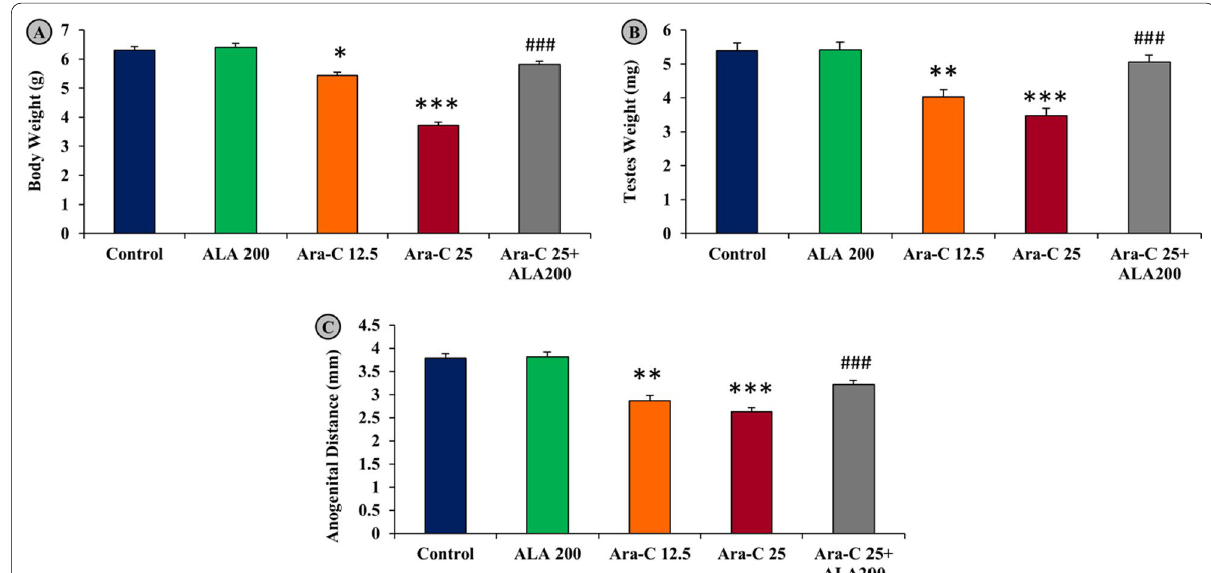
Fig. 3 Effect of Ara-C and ALA on fetal A bodyweight, B testicular weight and C anogenital distance. All the values are expressed as mean ( n 10). *** P < 0.001 versus control, ** P < 0.01 versus control, * P < 0.05 versus control; ### P < 0.001 versus Ara-C 25 mg/kg. ALA alpha-lipoic acid, = Ara-C